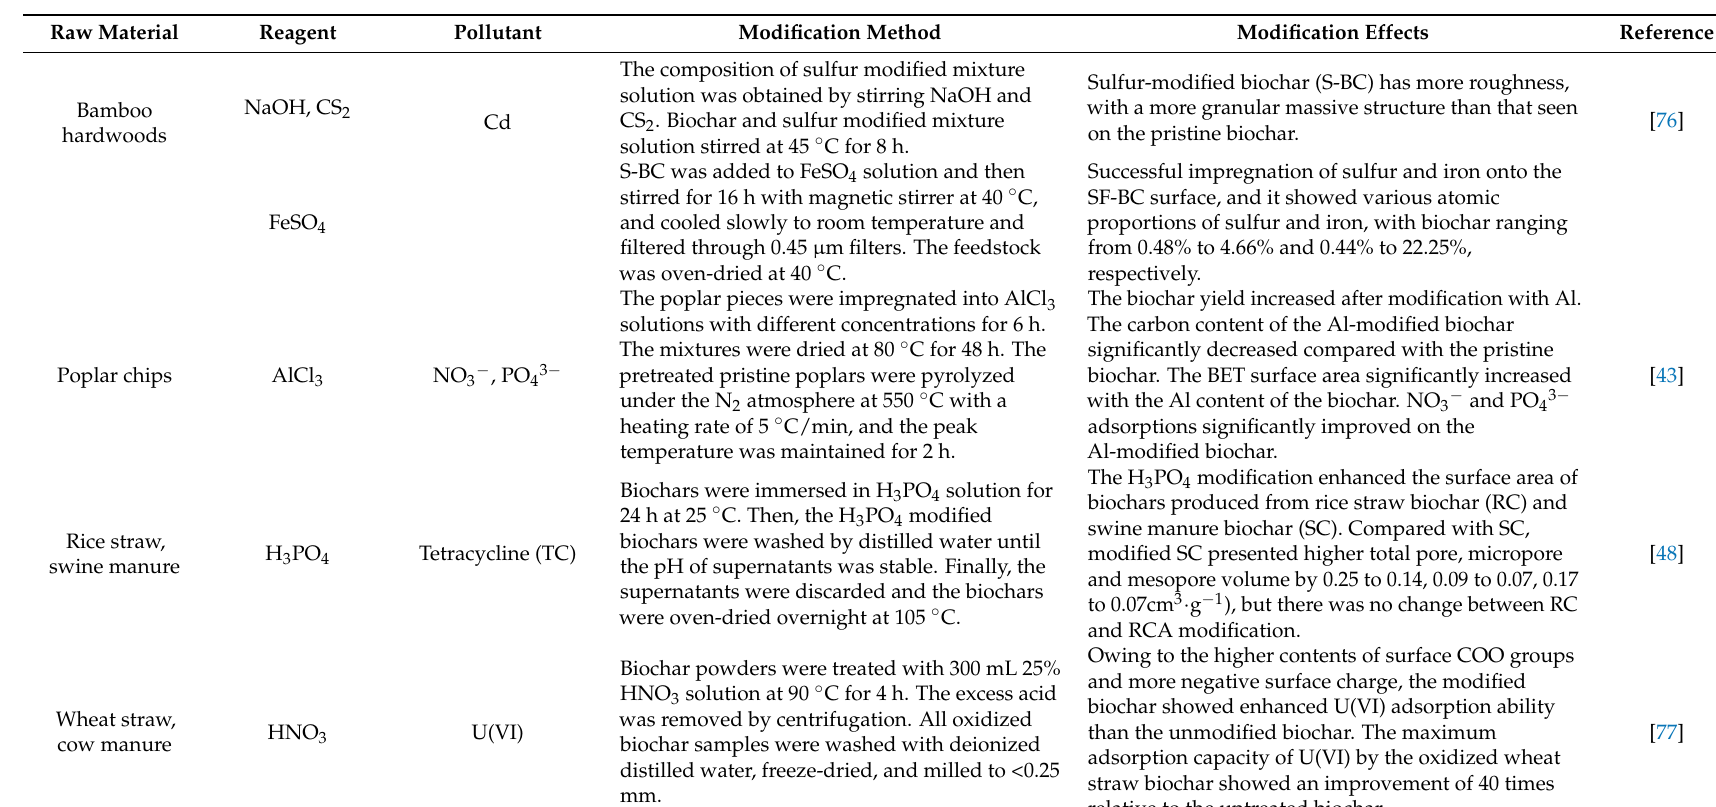
Table 2. Preparation of different modified